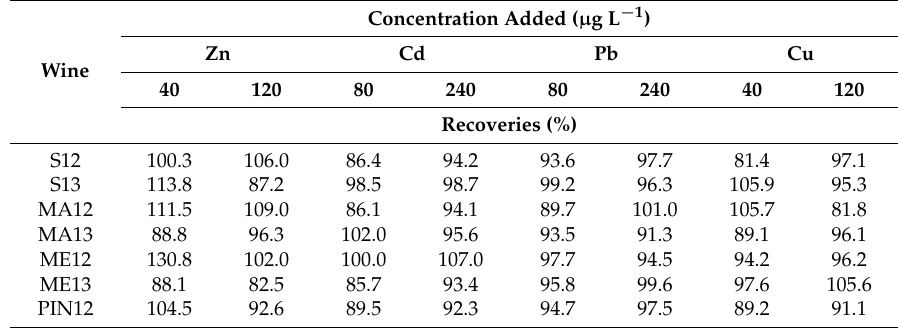
Table 2. Recovered levels (%) of Zn, Cd, Pb and Cu of seven wine with the proposed method.